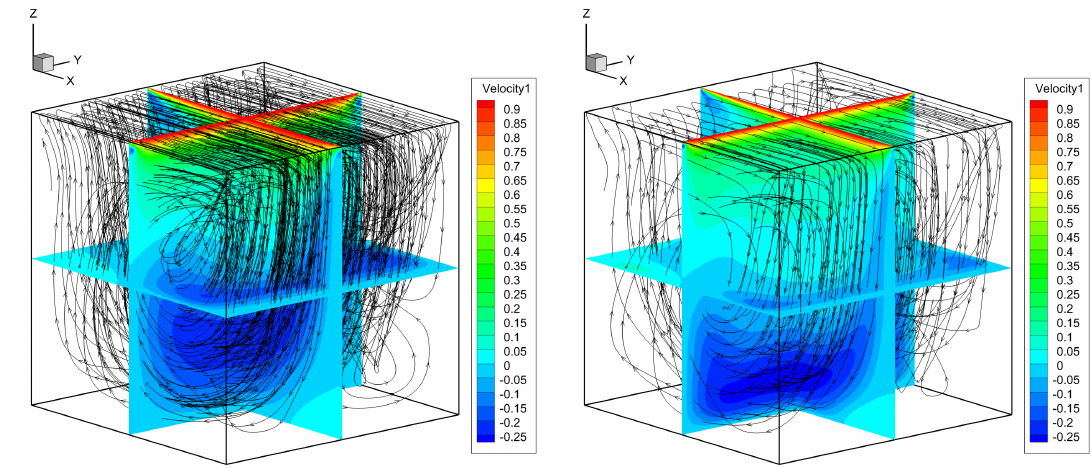
Figure 13. Streamlines and velocity contour colors (m/s) for the three–dimensional lid–driven cavity at Re = 400 ( left ) and Re = 1000 ( right ) at time t = 40.